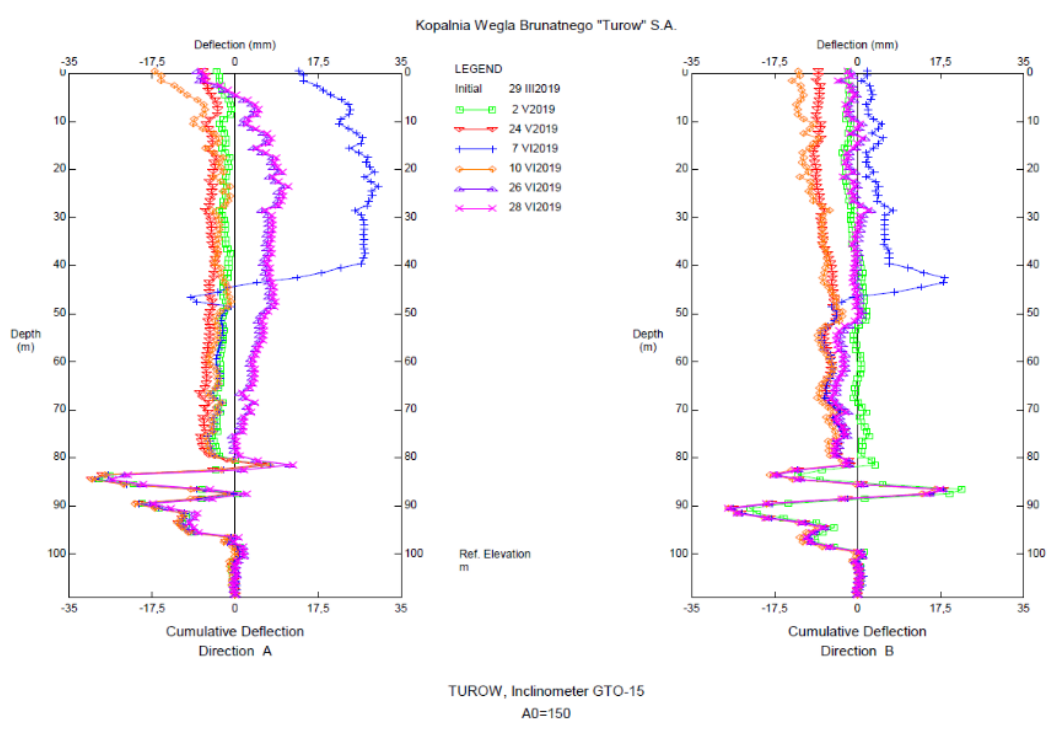
Figure 7: Subsurface displacements on inclinometer GTO-15.